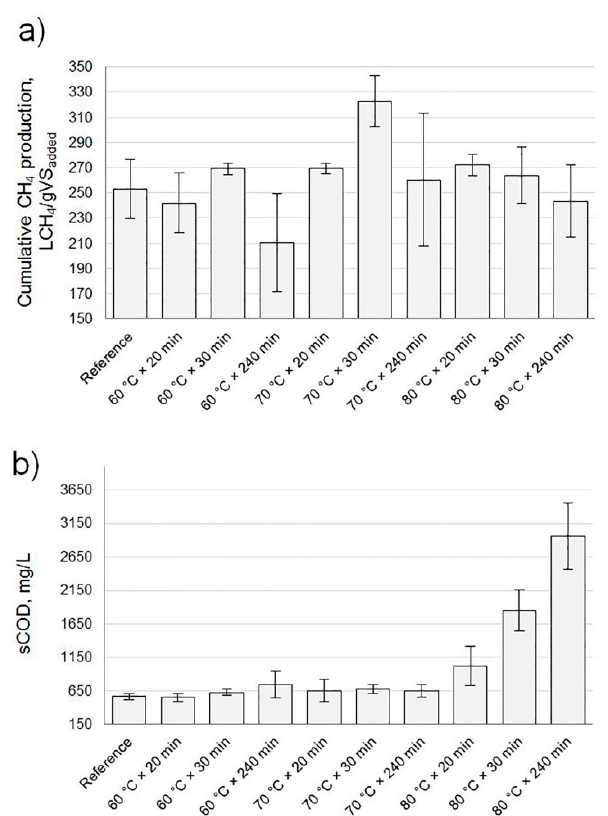
Figure 2. ( a ) Cumulative methane production for the assayed conditions; ( b ) soluble fraction chemical oxygen demand (sCOD) of the digestates after 30 days of digestion. Note: all conditions (including reference) included 10 mg H 2 O 2 / g total solids (TSs). VS, volatile solid.